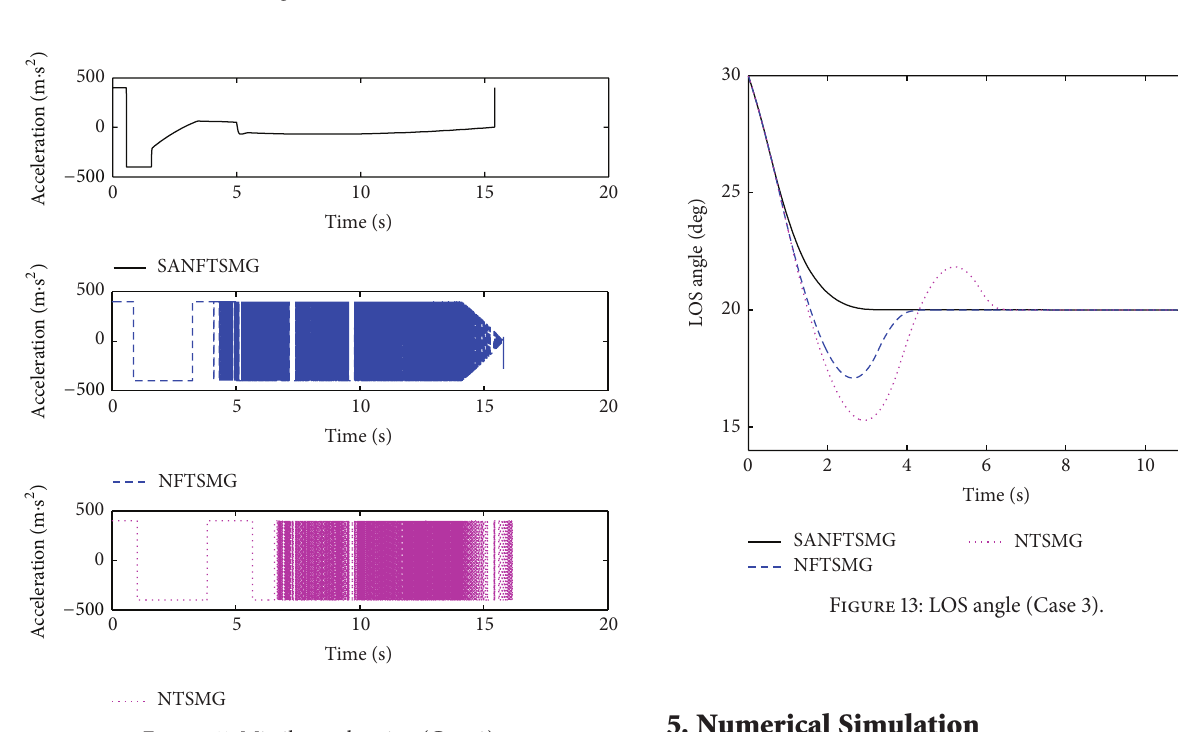
Figure 10: Sliding mode manifold (Case 2).